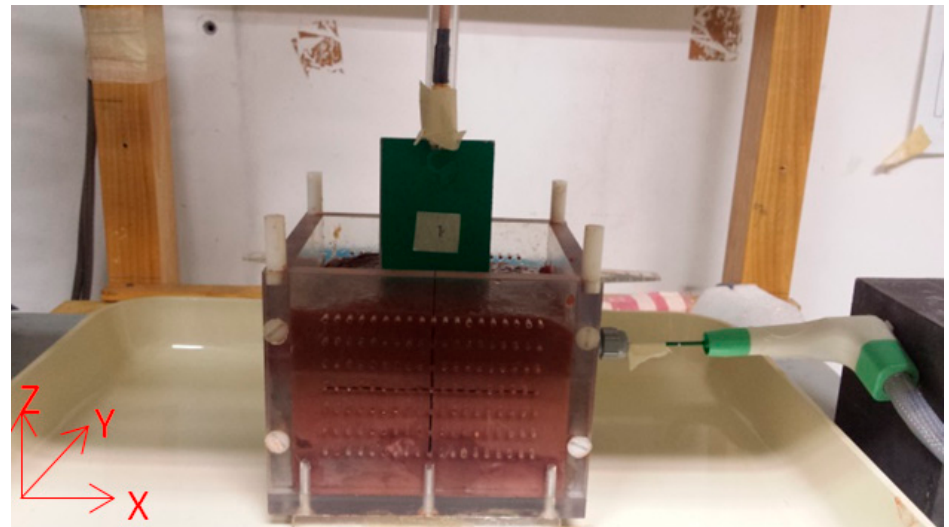
Figure 2. Plastic box containing an ex vivo tissue specimen of bovine liver. The MWT antenna is visible on the top of the specimen connected to the arm of the scanning system. The MTA applicator is visible on the right of the specimen, partially inserted into it. The reference system is shown on the bottom left in red color.